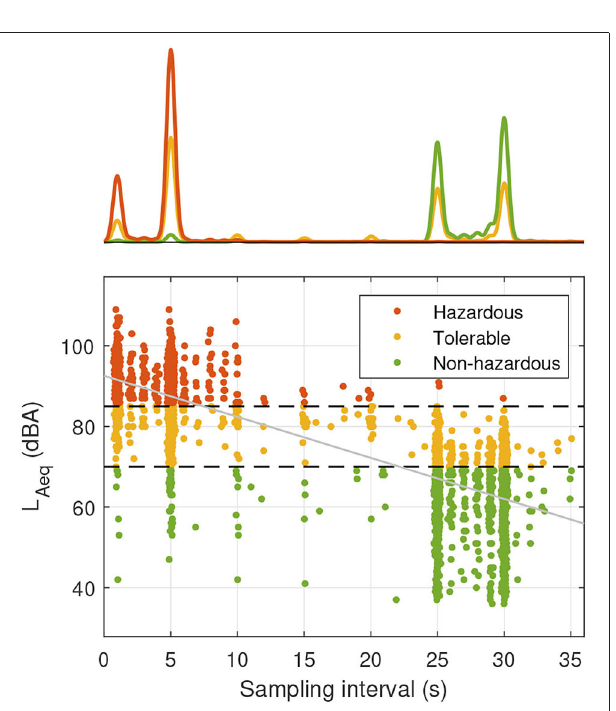
FIGURE 3 | Scatter plot with histogram representing the relationship between smartwatch samples L Aeq and sampling interval for different sound pressure level categories. The smartwatch sampling intervals are automatically adjusted by the device and have integer values of seconds; jitter was added to improve visibility. The black dashed lines indicate the threshold values for sound pressure level categorization (70 and 85 dBA, respectively). The least-squares regression line is depicted in gray.